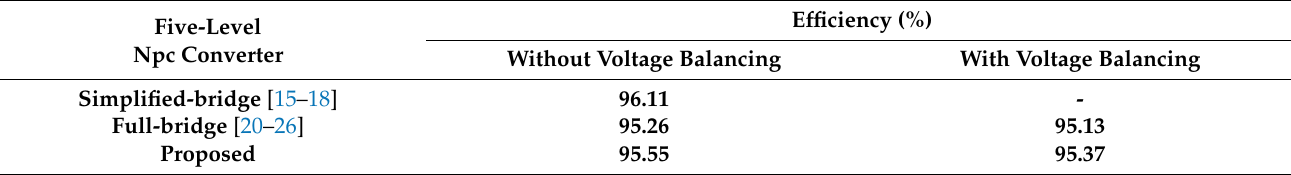
Table 4. Figure of merit based on the efficiency of different five-level NPC converters with and without the voltage balancing of the DC-link split